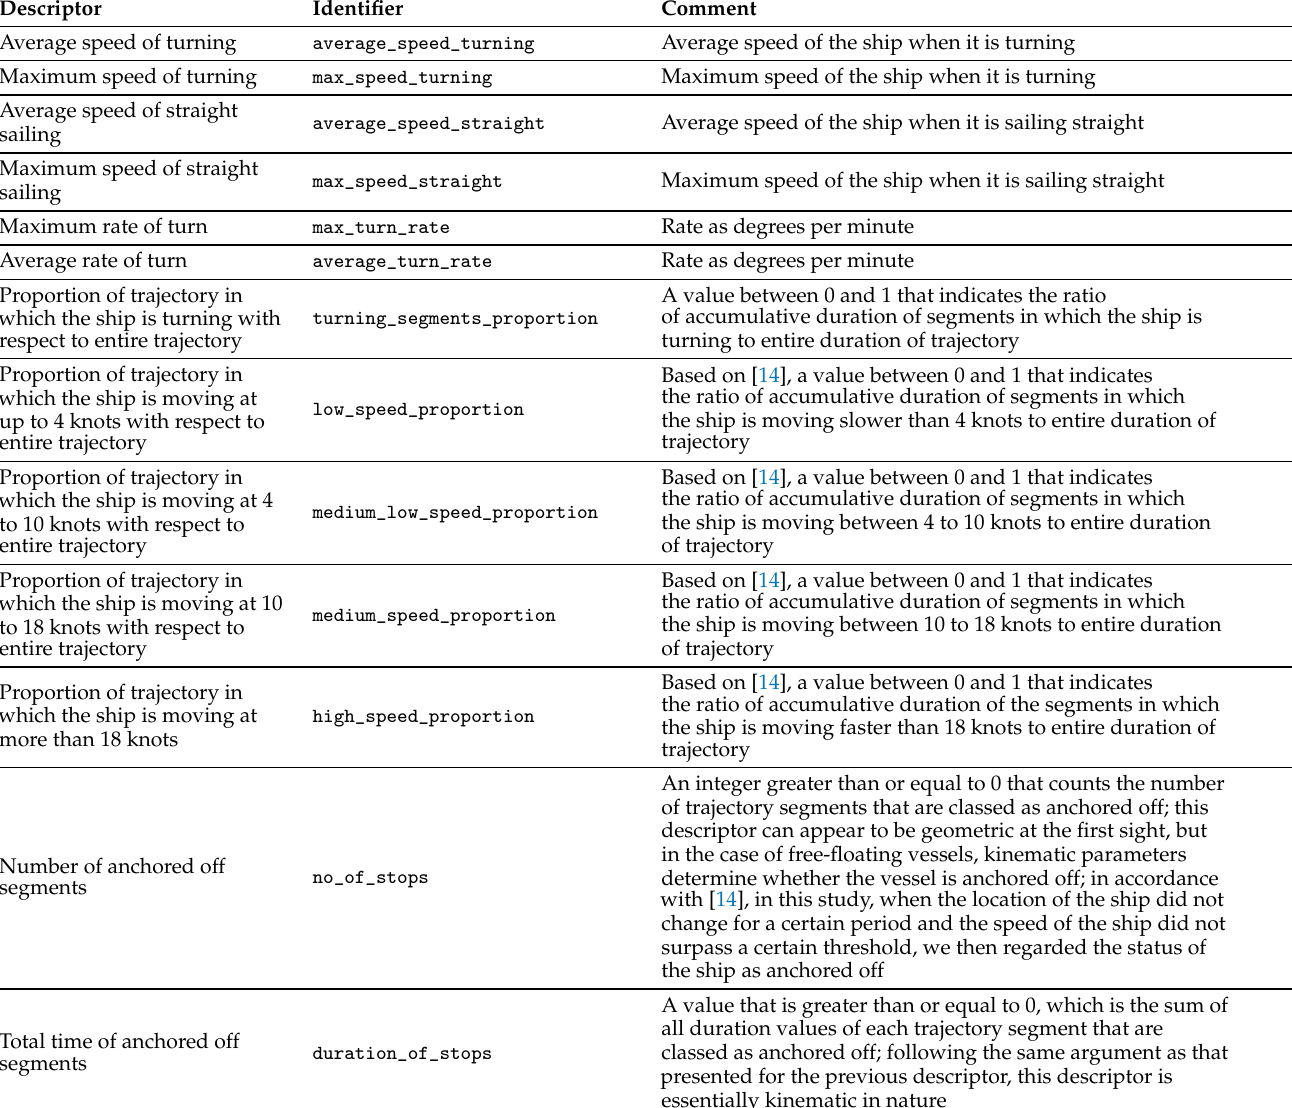
Table 3. The list of kinematic descriptors that were used in this